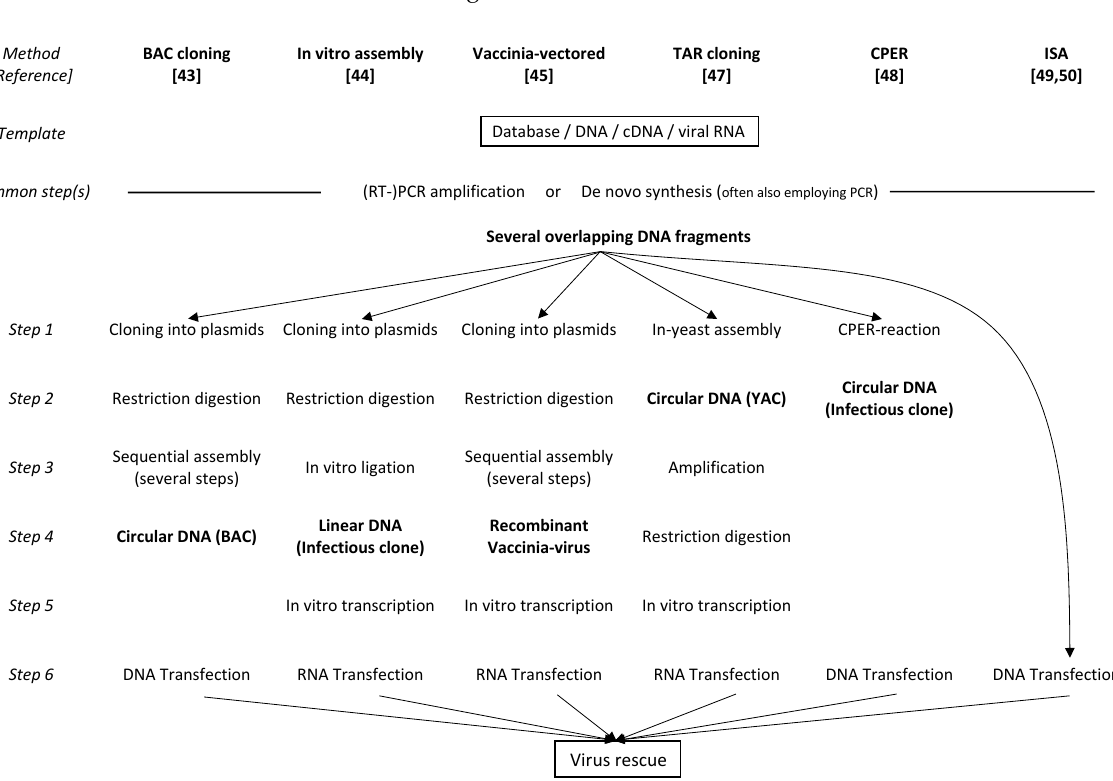
Figure 1. Comparison of major technologies for rescuing coronaviruses